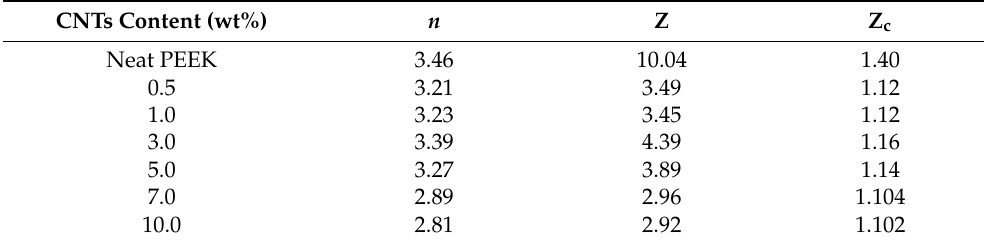
Figure 5. Avrami plots of ln( − ln(1 − X t )) versus lnt at various cooling rates under non-isothermal crystallization. Table 3. Kinetics parameters of PEEK for various filler content.